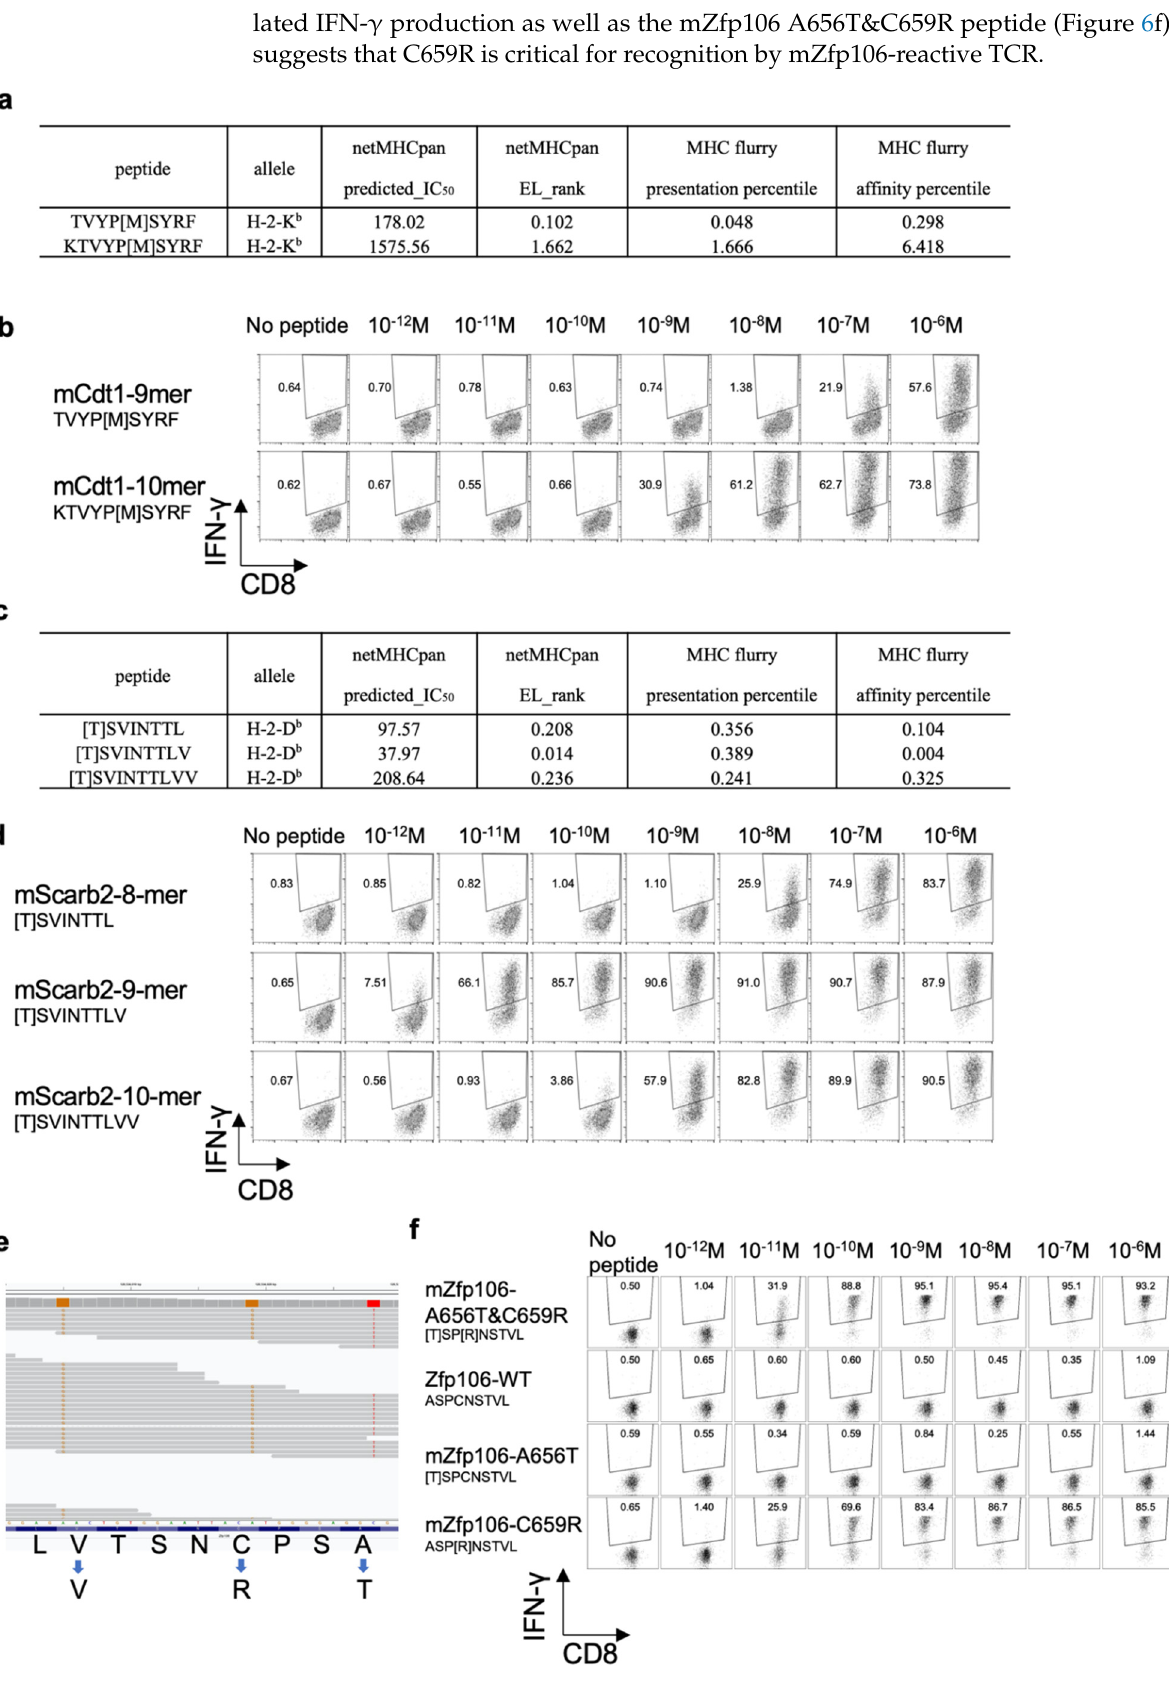
Figure 6. Functional affinities of three neoantigens: ( a ) MHC class I binding prediction values of 9- mer and 10-mer mCdt1 epitopes. ( b ) mCdt1-reactive CD8 + T cells were stimulated with 9-mer or 10- mer mCdt1 peptides at the indicated concentrations. IFN- γ production was evaluated by intracel- lular cytokine staining. ( c ) MHC class I binding prediction values of 8-mer, 9-mer, and 10-mer